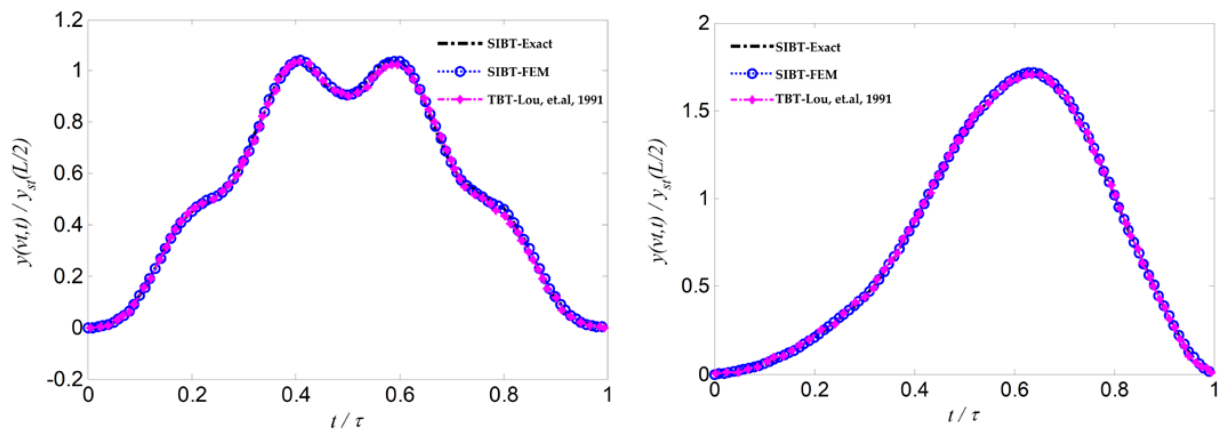
Figure 11. Normalized displacement of the beam. Table 4. D3 for different cross-section and moving speeds.